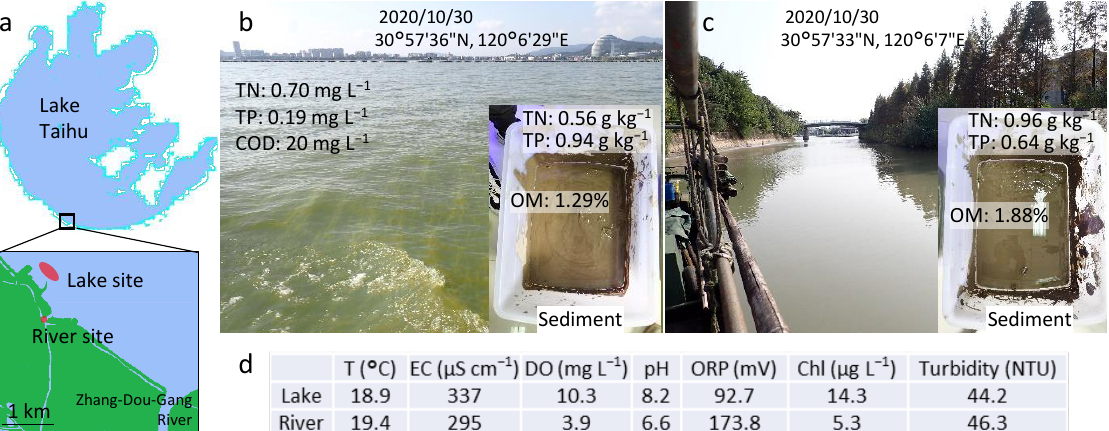
Figure 1. Water and sediment sampling locations in south Lake Taihu, China and an inflow river (( a ) map, ( b ) lake site, ( c ) river site, ( d ) water quality at sampling time). TN: total nitrogen, TP: total